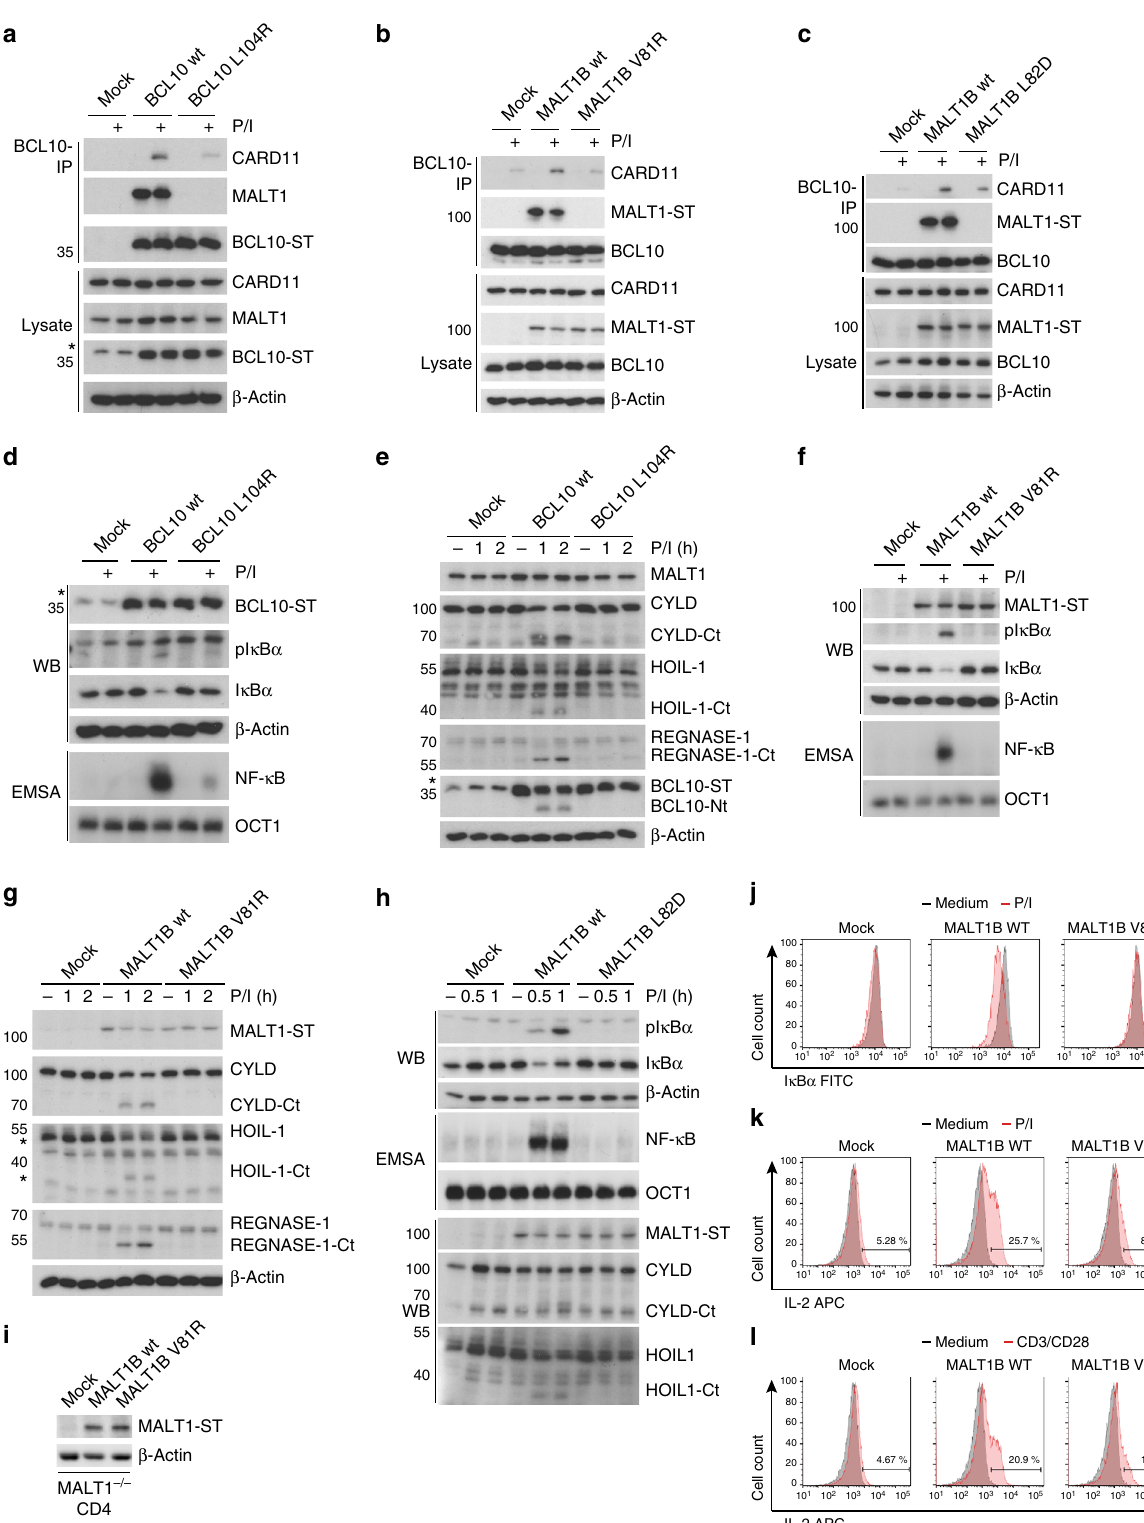
unambiguous fi t of the MALT1 Ig2-paracaspase-Ig3 domains.